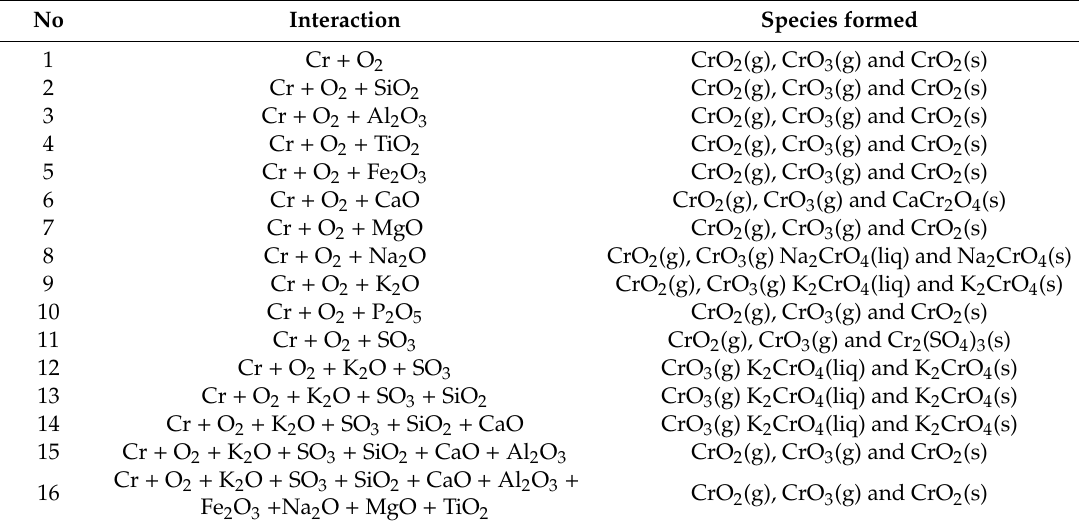
Table 4. Interaction of chromium with mineral compounds in fly ash (FA A) after combustion process (T = 100 ◦ C and P = 1